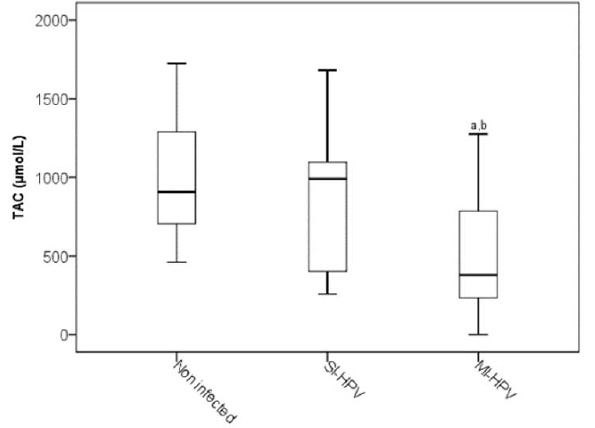
Figure 2. Total antioxidant capacity in study groups. The significance test is the Kruskal–Wallis test for non-distributed variables ( p < 0.05). a Infected HPV group vs. non-infected group; b SI-HPV group vs. MI-HPV group.